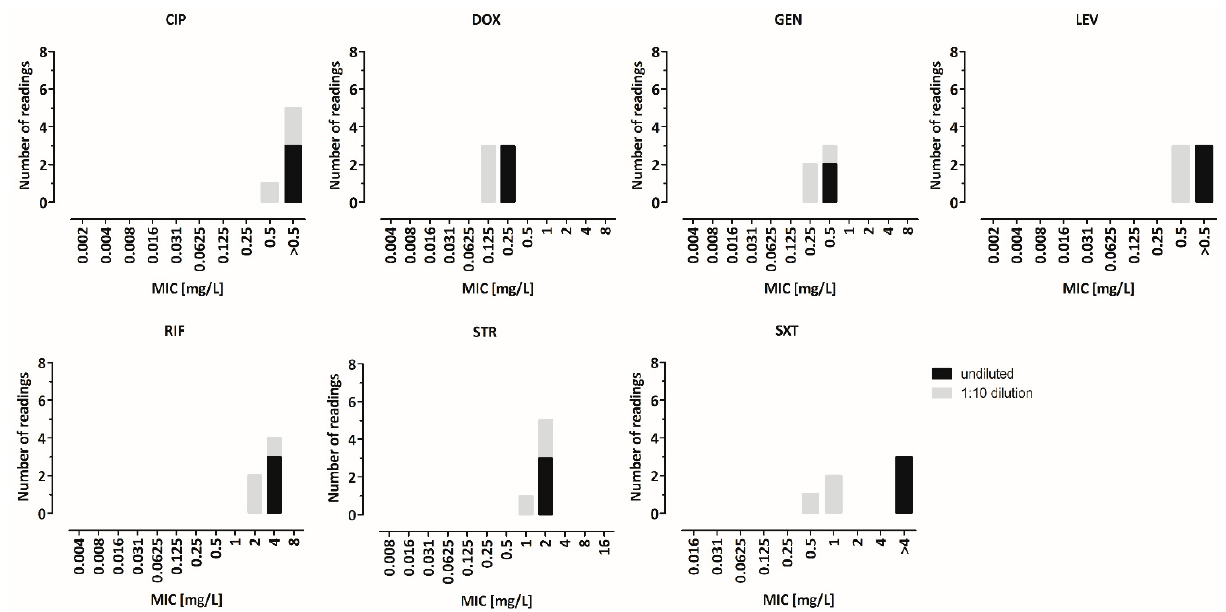
Figure 1. Comparison of different inoculum cell counts in the BMD. BMD was performed in triplicates with B. melitensis reference strain ATCC 23456 using undiluted McFarland 0.5 suspension (in the following referred to as “undiluted”) vs. 1:10 diluted suspension (in the following referred to as “1:10 dilution”) for inoculation. The MIC values were determined after incubation in a 5% CO 2 atmosphere for 48 h. No differences in MIC values were observed for rifampicin (2 to 4 mg/L), gentamicin (0.25 to 0.5 mg/L) or streptomycin (1 to 2 mg/L). For doxycycline, the 1:10 dilution led to lower MIC values (0.125 mg/L vs. 0.25 mg/L). For levofloxacin and ciprofloxacin, the 1:10